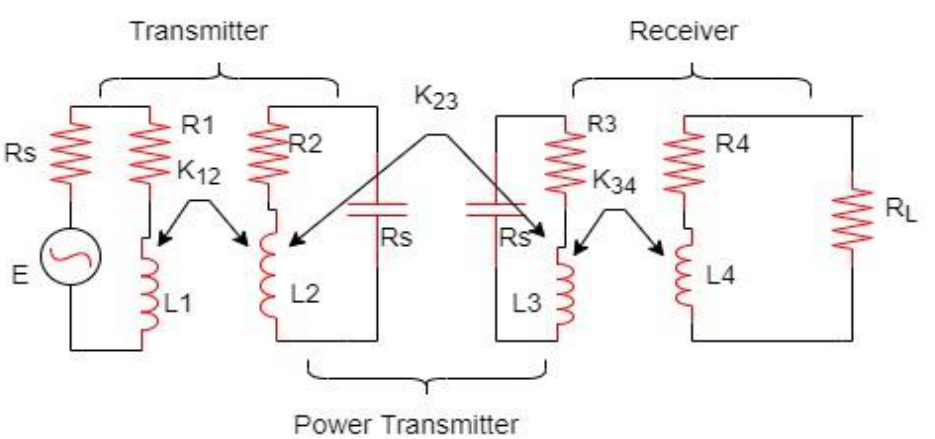
Figure 4. WPT system without using any impedance-matching circuits.